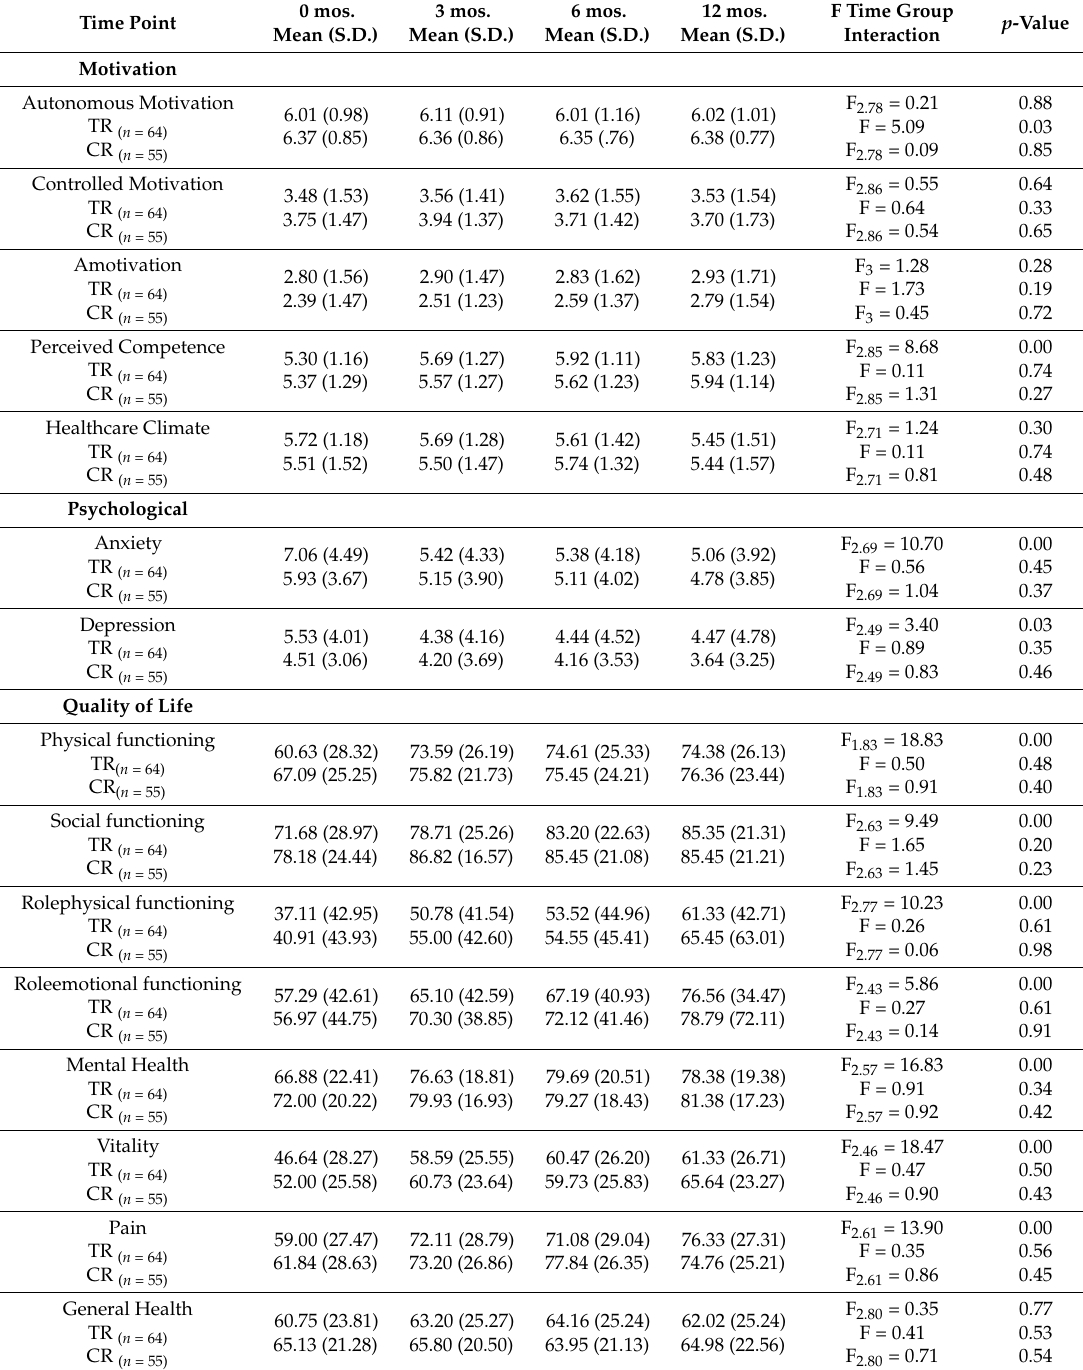
Table 2. Analysis of changes over time in motivation, anxiety, depression, and quality of life for Telerehabilitation (TR) and Conventional Rehabilitation (CR)